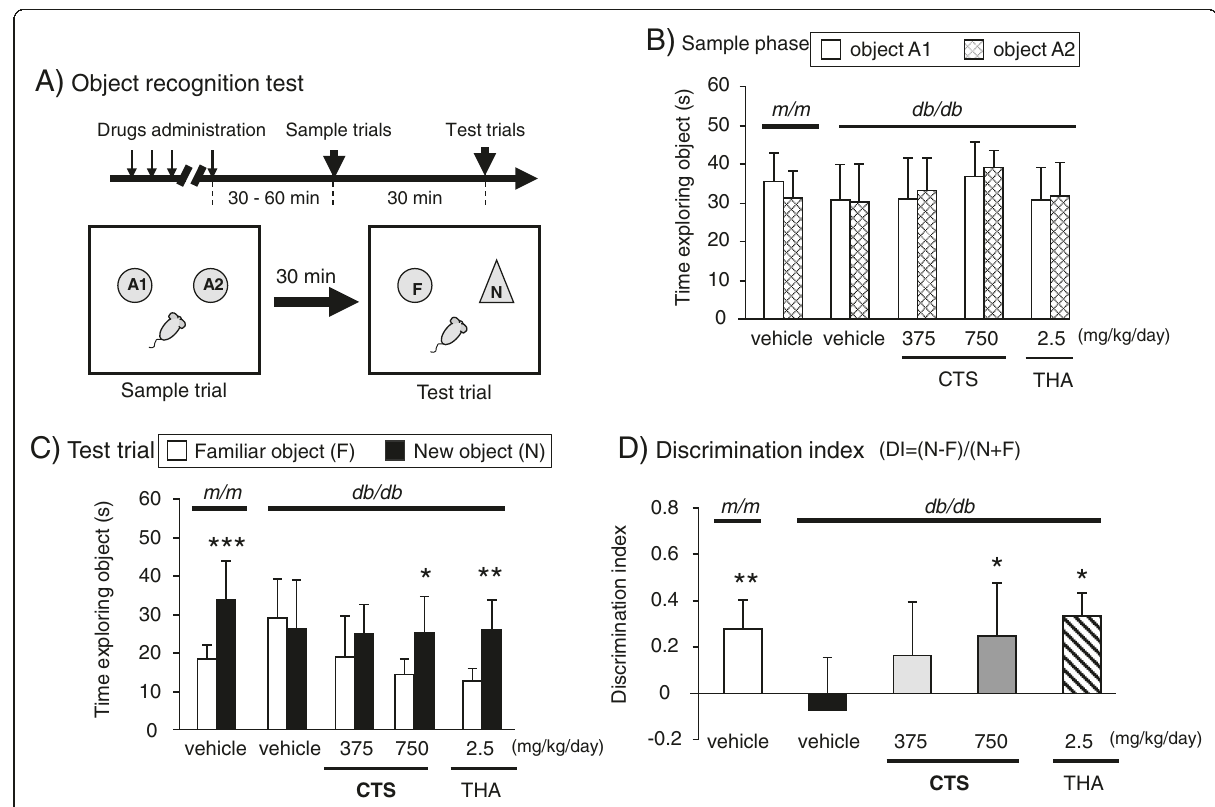
Figure 2 Effects of CTS and THA on object discrimination performance of db/db mice in the ORT. The ORT was conducted on days 19 – 21 after starting drug administration. Each datum represents the mean ± S.D. (6 – 9 mice per group). ( A ) The data from the sample trials of the ORT. The animal was placed into the arena where two identical sample objects made of glass (objects A1 and A2) were placed in two adjacent corners of the arena and was allowed to explore for five minutes. ( B ) The data from the test phase trials conducted ten minutes after the sample phase trials. In the test phase trials, the time animals spent exploring a familiar object or a new object was measured during a 5-minute observation period. *** P < 0.001 and ** P < 0.01 vs. the time spent exploring a familiar object (paired t -test). ( C ) Discrimination index (DI) in the ORT. DI was calculated as described in the text. ** P < =0.01 vs. vehicle-treated m/m group ( t -test). * P < 0.05 vs. vehicle-treated db/db group